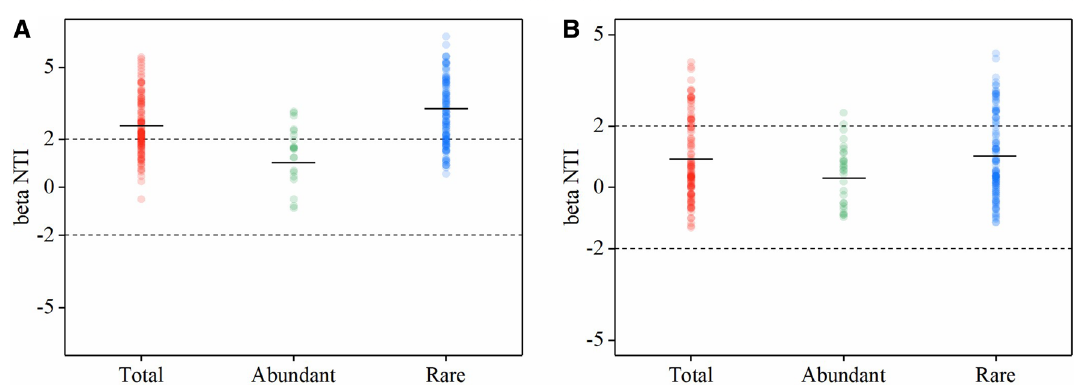
Figure 4. Distribution of beta Nearest Taxon Index (beta NTI) indicating assemblage processes of the total, abundant, and rare taxa in soil bacterial of tobacco monoculture ( A ) and tobacco-rice rotation ( B ). Black lines represent the median value of each taxa. Dash black lines (statistically significant if > 2 or < − 2) represent a 95% confidence interval around the expected neutral assembly. Total whole bacterial communities, Abundant abundant taxa, Rare rare